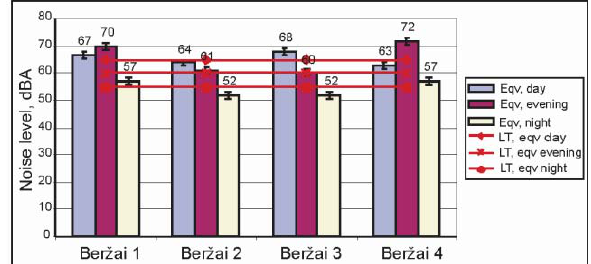
Fig. 4. Dynamics of equivalent noise levels in Berţai street within twenty four hours